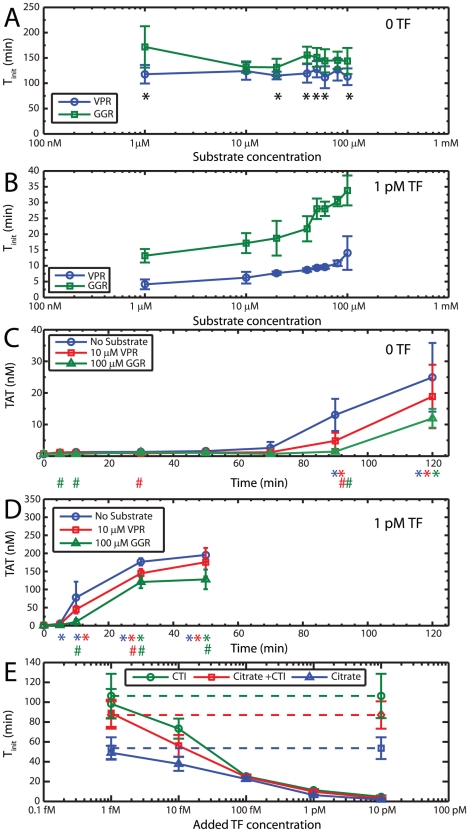
Validation of experimental protocol.(A) A titration of the fluorogenic substrates Boc-VPR-MCA (blue circle) and Z-GGR-MCA (green square) with 0 added TF showed a mild inhibitory influence of Z-GGR-MCA. *s indicates statistically significant difference (p<0.05) between initiation times detected with the two different substrates. (B) A titration of the fluorogenic substrates Boc-VPR-MCA and Z-GGR-MCA with 1 pM added TF showed inhibitory influence of both substrates where Boc-VPR-MCA was found to be the better substrate to detect initiation and exhibited little inhibition at 10 µM concentration. (C) TAT formation with 0 added TF, in the absence and presence of fluorogenic substrates showed less inhibitory influence of Boc-VPR-MCA on initiation defined by a burst in TAT compared to Z-GGR-MCA. Absolute [TAT] after initiation is decreased in the presence of either substrate. (D) TAT formation with 1 pM added TF, in the absence and presence of fluorogenic substrates showed decreased [TAT] during the propagation phase of coagulation in the presence of either substrate. Initiation detected by TAT correlated well with Ti determined by our fluorogenic assay. In panels C and D, * indicates [TAT] significantly greater than baseline levels (p<0.05) and # indicates statistically significant differences compared to no substrate (blue). Experiments in panels A, B, C and D were carried out with blood from the same phlebotomy. (E) TF titration done in blood anticoagulated with CTI alone (green), Citrate + CTI (red) and Citrate alone (blue). Dashed lines indicate controls with no added TF. No significant difference was detected in titrations done with and without citrate, showing no evidence of inhibition by the anticoagulant. Effects of the contact factor pathway were apparent only below 100 fM added TF.